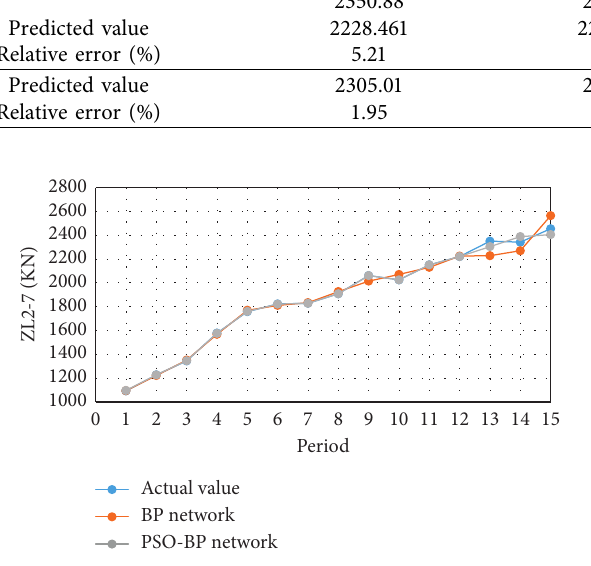
Figure 13: Comparison of actual and predicted values.